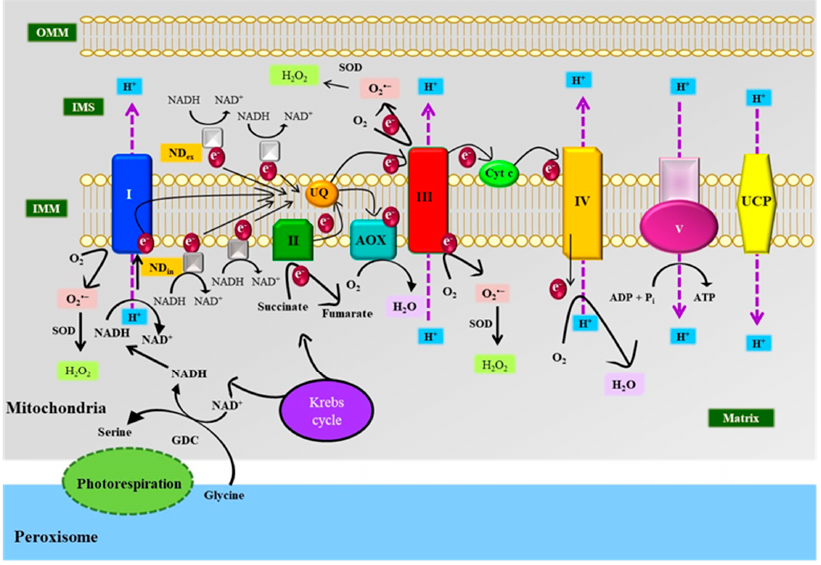
Figure 5. Mitochondrial electron transport chain (mtETC) mediated ROS production and alternative pathway under abiotic stress. The process, such as photorespiration and Krebs cycle, results in the generation of NADH and/or succinate which enters mtETC at complex I or complex II, respectively. At complex I, NADH converts into NAD + and H + with the generation of an electron. At complex II, succinate is changed to fumarate with the electron generation. An electron from both complex I and II get transferred to UQ from where they move to complex III and then to complex IV via Cyt c. The electron at complex I and